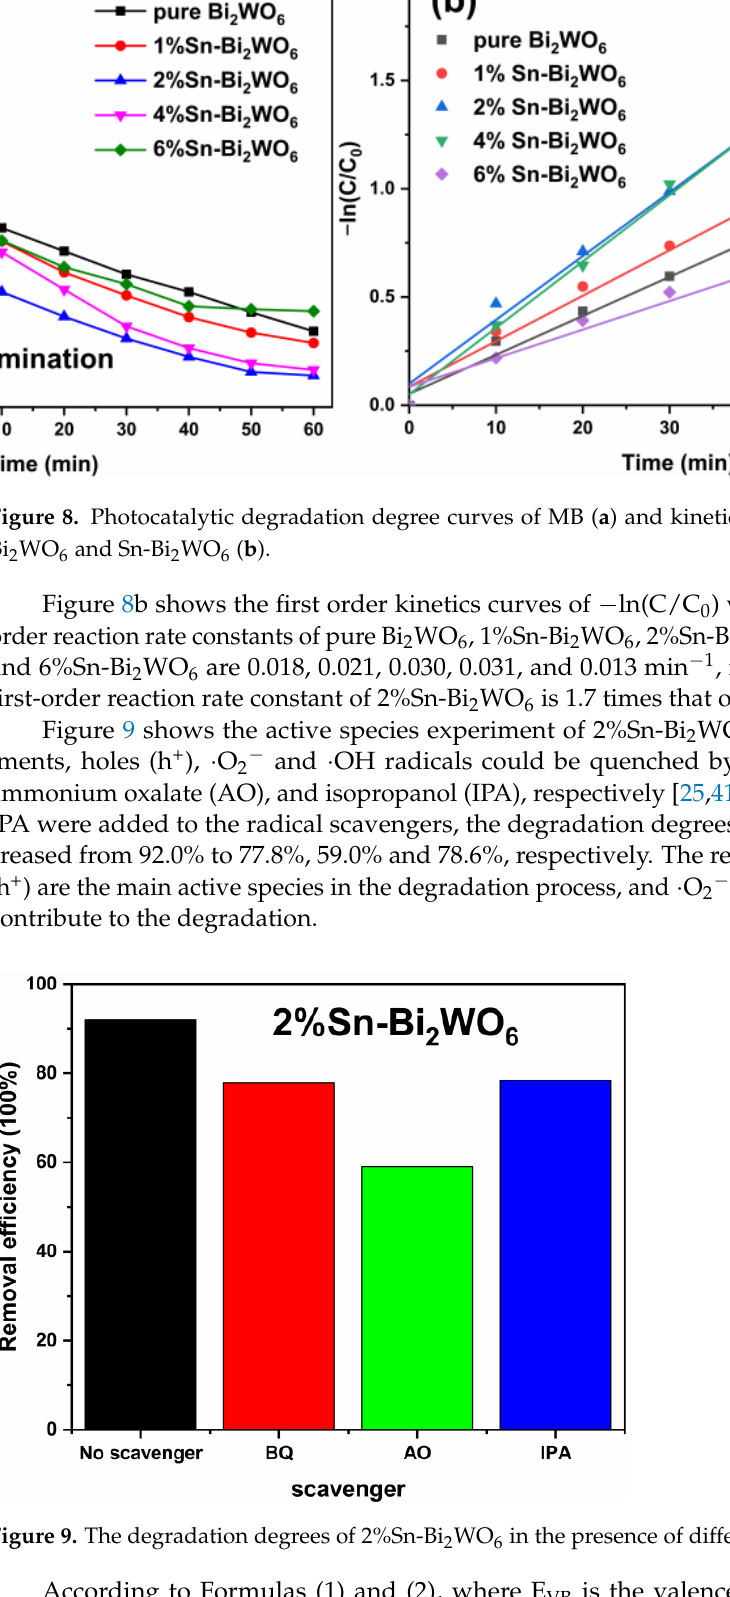
Figure 9. The degradation degrees of 2%Sn-Bi 2 WO 6 in the presence of different scavengers. According to Formulas (1) and (2), where E VB is the valence band potential, E CB is the conduction band potential, E 0 is the free electron energy on the hydrogen scale (E 0 = 4.5 eV); E g is the bandgap energy of the photocatalytic material, and X is the absolute electro- negativity of the semiconductor [46]. E CB = X − E 0 − E g /2